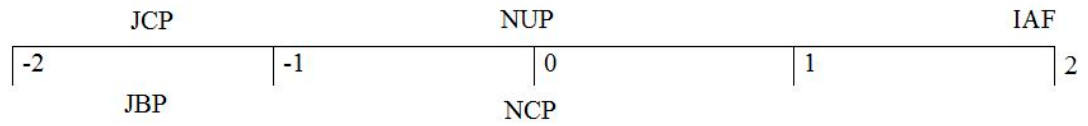
Figure 3. Jordanian political structure with respect to issues, 1993. EconLib: economic liberalism; CultLib: cultural liberalism; ReligInf: religious influence.